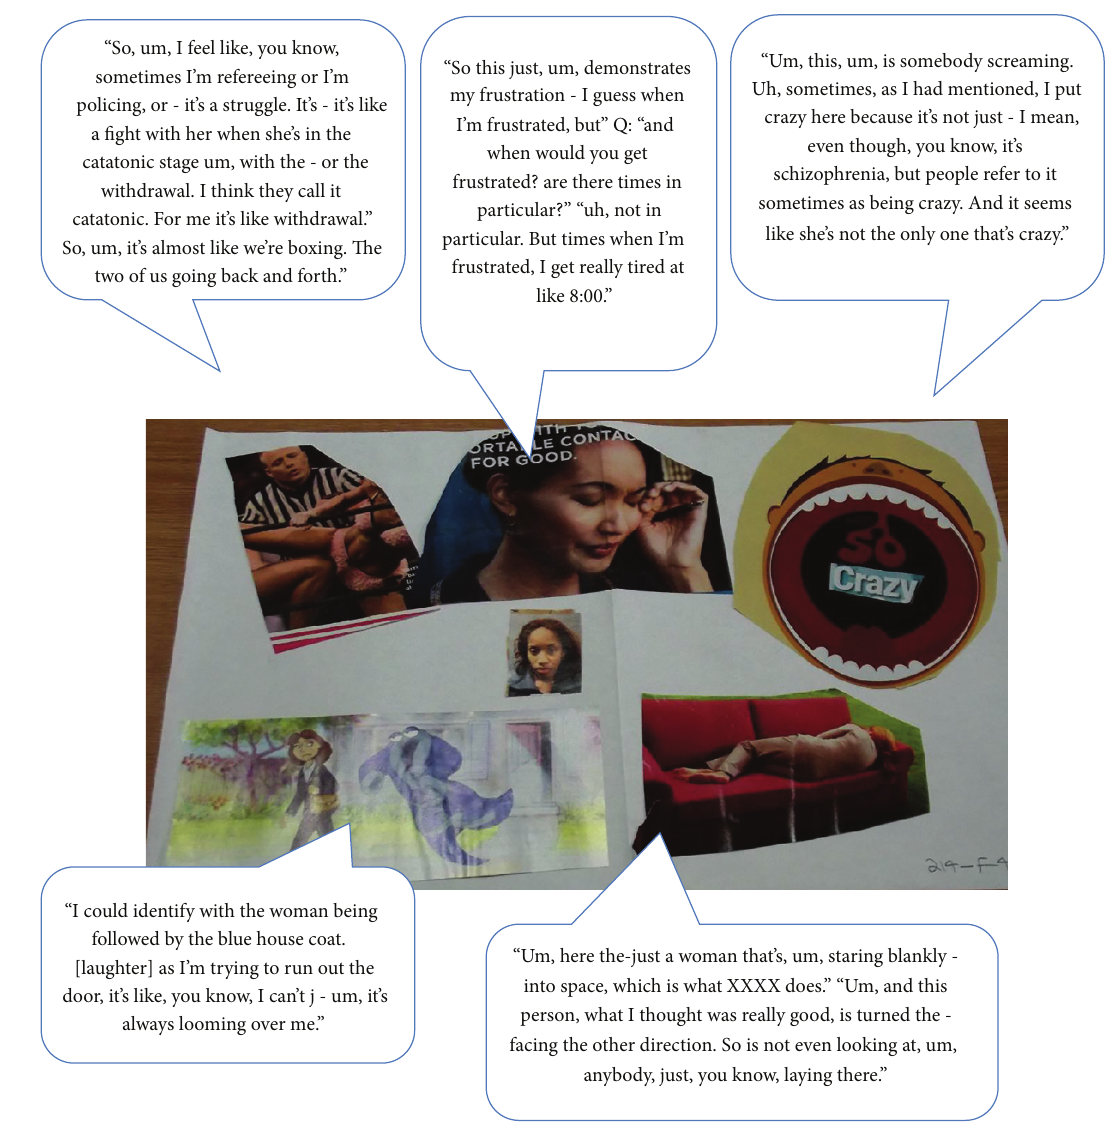
Figure 1: Caregiver ID: